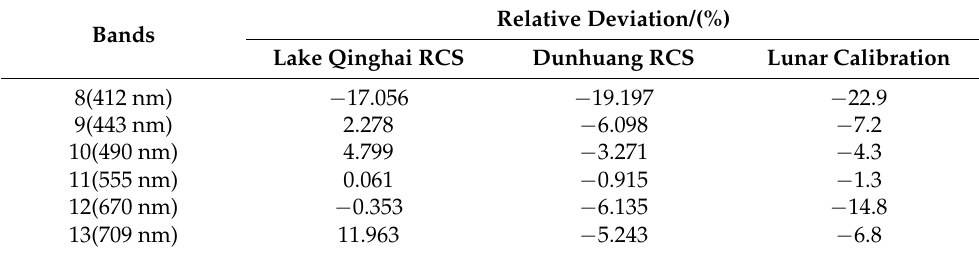
Figure 12. Calibration coefficients of three methods. Table 10. Relative deviation of three methods.